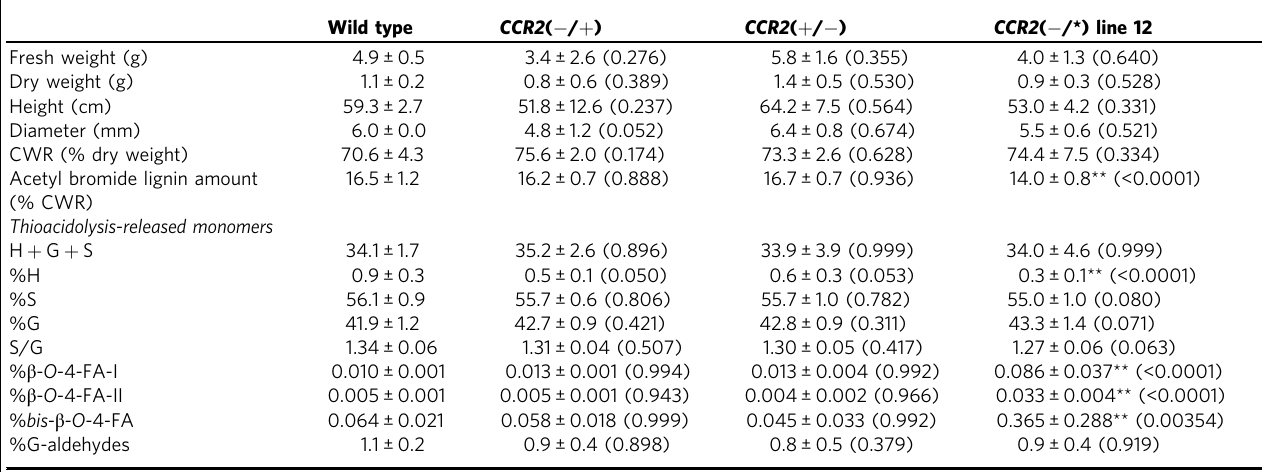
Fig. 5 Phenotype of poplar containing mono- and biallelic CCR2 mutations. Plants were grown for 11 weeks in the greenhouse. CCR2 ( + / − ) generated via CRISPR/Cas9 using gRNA2, CCR2 ( − / + ) and CCR2 ( − / − ) generated via CRISPR/Cas9 using gRNA3, and CCR2 ( − / − ) and CCR2 ( − /*) line 12 generated via CRISPR/Cas9 using gRNA1. gRNA1 targets the third exon of both CCR2 alleles whereas gRNA2 and gRNA3 target the fourth exon of the P. alba or P. tremula CCR2 allele, respectively. The status of the CCR2 alleles present in P. tremula × P. alba is denoted between the parentheses; the fi rst one represents that of the P. tremula allele, the second one that of the P. alba allele; + , wild type; − , knockout; *, protein-modi fi ed. The plants shown are representative for seven biologically independent samples for wild type, CCR2 ( + / − ), CCR2 ( − / + ), CCR2 ( − / − ) (gRNA1), and CCR2 ( − /*) line 12. One plant was available for CCR2 ( − / − ) (gRNA3). Scale bar = 10 cm. Table 2 Biomass and cell wall composition of CCR2 ( − / + ), CCR2 ( + / − ), and CCR2 ( − /*) line 12